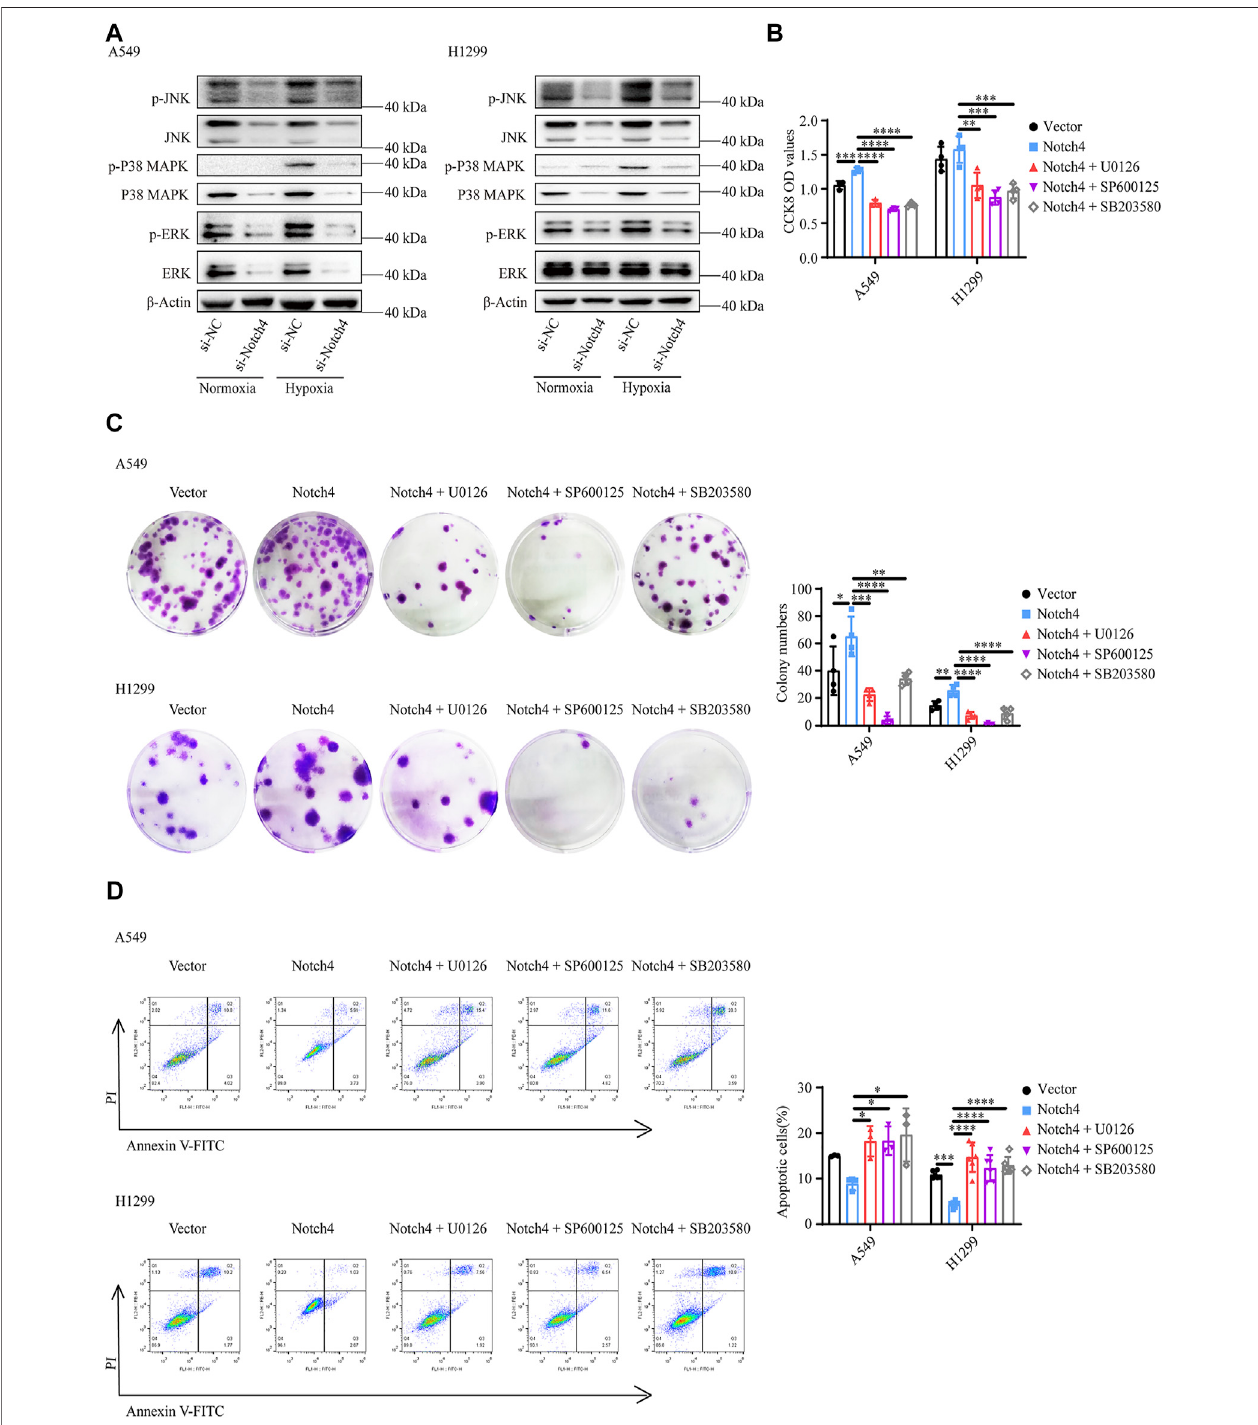
FIGURE5| ERK,JNK,andP38MAPKsignalingmediatetheregulationofNotch4overexpressiononA549andH1299cellsproliferationandapoptosis. (A) TheMAPKsignaling pathwayweredetectedinA549andH1299cellstransfectedwithsiRNAagainstNotch4ornegativecontrolsiRNA. (B) CellviabilitywereexaminedinA549andH1299cellstransfected withNotch4plasmidornegativecontrolplasmidco-treatmentwithERK(U0126),JNK(SP600125),orP38(SB203580)MAPKpathwayinhibitorsbyusingCCK-8assay.( n (cid:2) 3 – 4). (C) ColonyformationassaywasperformedinA549andH1299cellstransfectedwithNotch4plasmidornegativecontrolplasmidco-treatmentwithU0126,SP600125,orSB203580 for24 h( n (cid:2) 4). (D) TheAnnexin-V/PIassaywasperformedinA549andH1299cellstransfectedwithNotch4plasmidornegativecontrolplasmidco-treatmentwithU0126,SP600125, orSB203580for24 h( n (cid:2) 3 – 6).Analysesofapoptosisincludingearlyapoptosis(Annexin-VpositiveandPInegative)andlateapoptosis(Annexin-VpositiveandPIpositive)wereshown. Datawerepresentedasmeans ± SD.* p < 0.05,** p < 0.01,*** p < 0.001,**** p < 0.0001.CCK-8,CellCountingKit-8;PI,propidiumiodide;si-NC,negativecontrolshortinterferingRNAs (siRNA); si-Notch4, the siRNA against Notch4. Vector, negative control plasmid; Notch4, Notch4 plasmid. ERK, extracellular signal-regulated kinase; JNK, c-Jun N-terminal kinase; MAPK, mitogen-activated protein kinase.